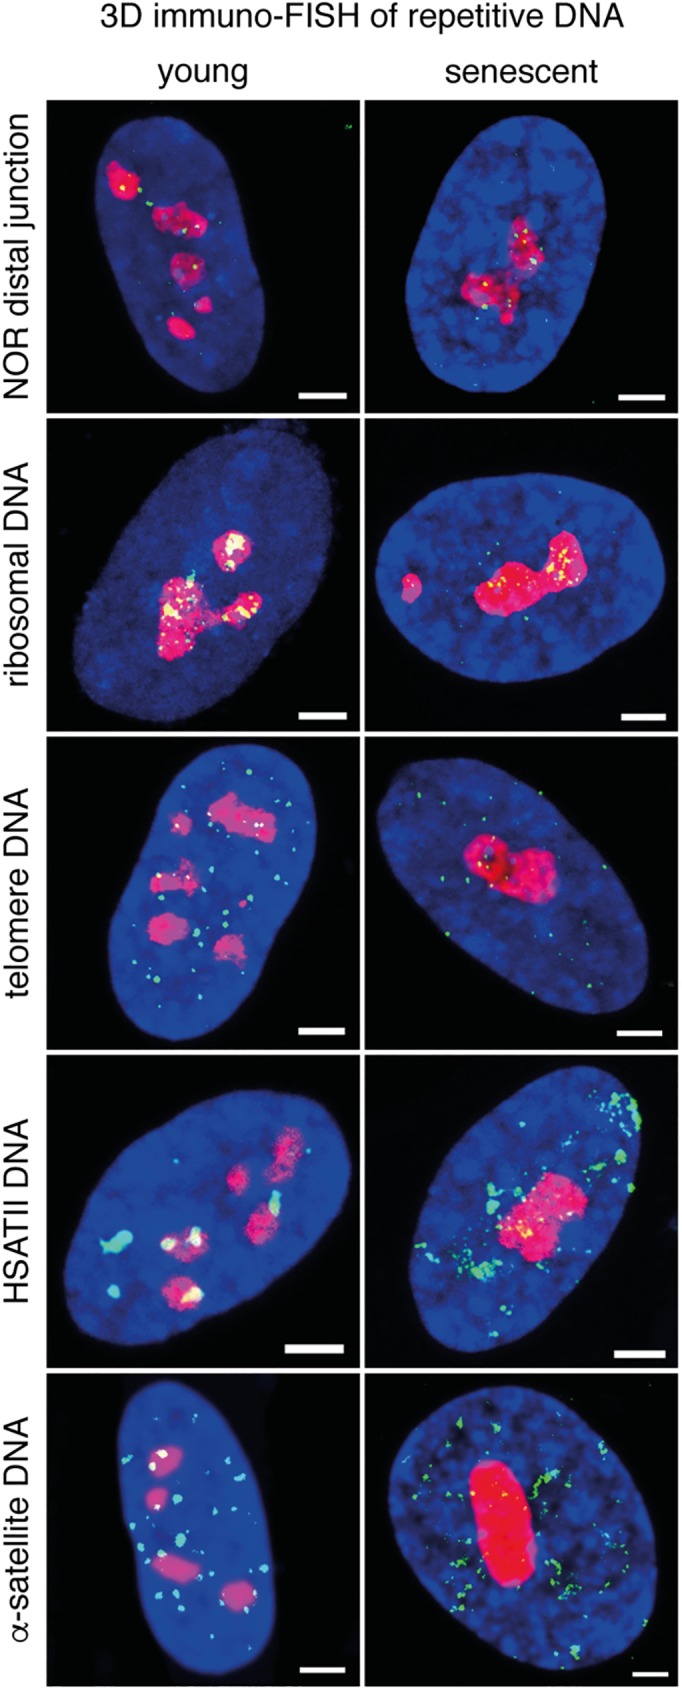
Nucleolus—satellite repeat cluster interactions are impaired in senescent cells, whereas rDNA and telomeres do not display remarkable changes in nucleolus association frequency.Maximal intensity projections of Z-sections of representative confocal microscopy images are shown to aid the visualization of all repeat clusters within a single nucleus. Nucleolar staining is in red, DAPI counterstain in blue and FISH signals are in green on all images (scale bars: 1.6 μm). From top to bottom: The distal junction regions of NORs and rDNA repeat clusters remain associated with nucleoli in senescent cells. The signal intensity of telomeres is reduced in senescence, but their overall association with nucleoli does not show specific changes. HSATII and alpha-satellite repeat clusters display senescence-associated distension and reduced nucleolus association.